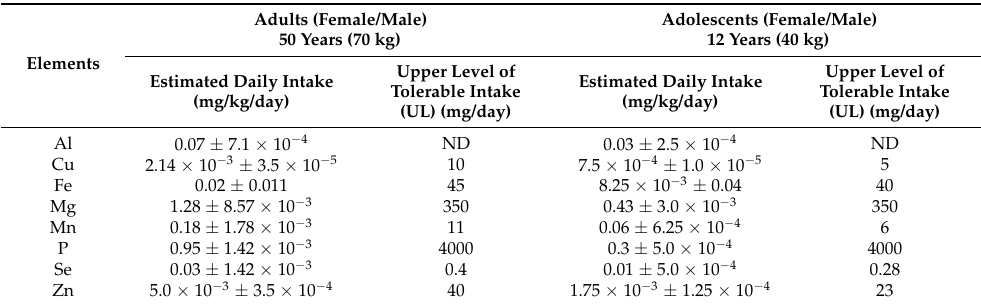
Table 5. Estimated daily intake ( EDI ) of each element via consumption of trunk xylem sap of the tree compared to Upper level of tolerable intake (UL) [35].